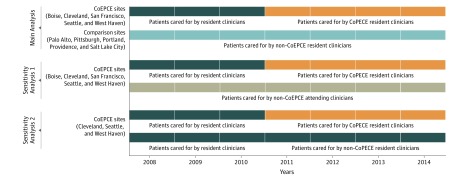
Cohort Construction for Main Analysis and Sensitivity AnalysesThe main analysis compared patients cared for by Centers of Excellence of Primary Care Education (CoEPCE) resident clinicians at CoEPCE sites with patients cared for by resident clinicians at non-CoEPCE sites. In sensitivity analysis 1, patients cared for by CoEPCE resident clinicians were compared with patients cared for by attending clinicians from the same CoEPCE sites. Sensitivity analysis 2 was conducted at 3 sites that divided their resident clinicians into 2 groups, some who participated in the CoEPCE initiative and some who did not. Patients cared for by CoEPCE resident clinicians were compared with patients cared for by non-CoEPCE resident clinicians from within these 3 sites.